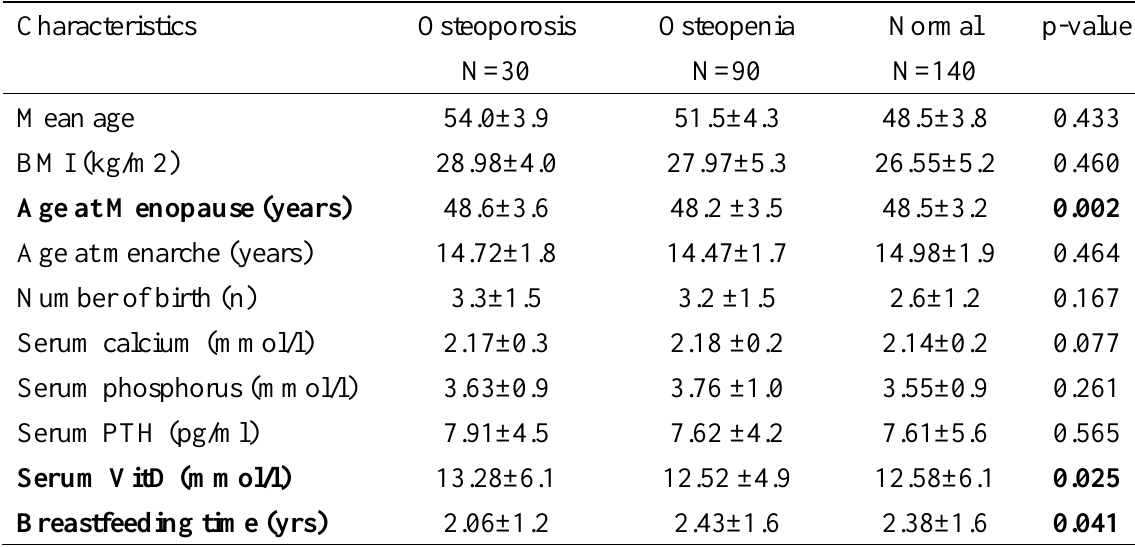
Table 1. Demographic and laboratory characteristics of